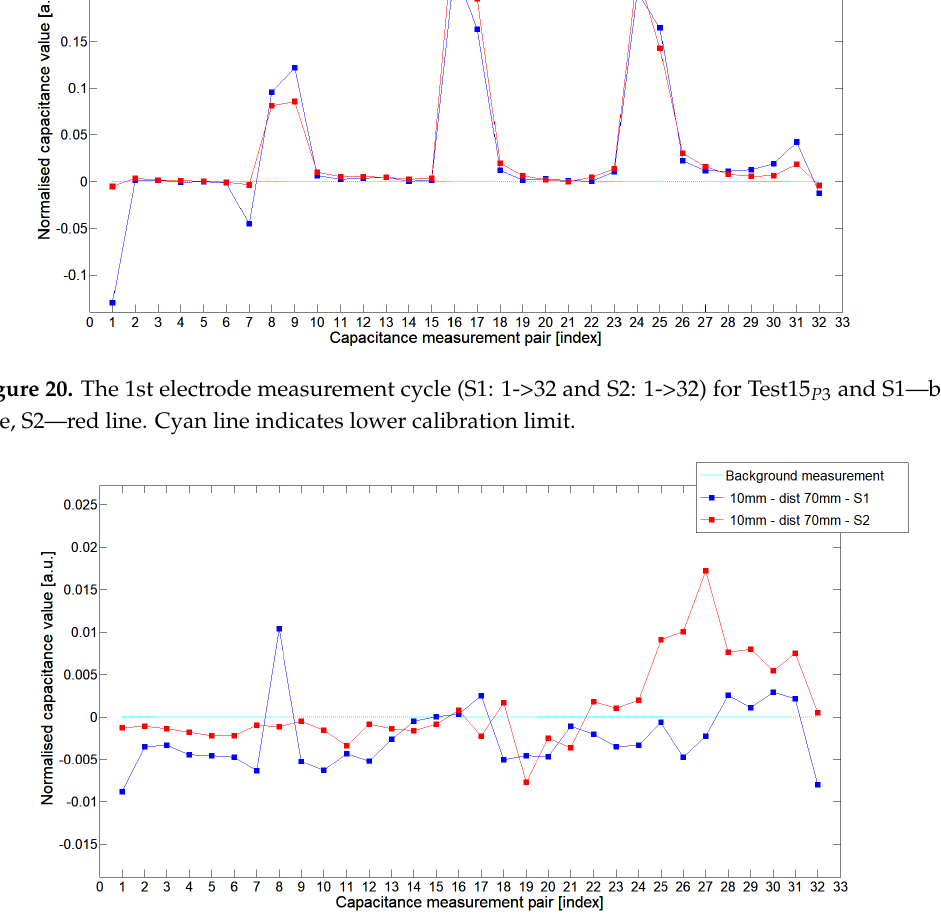
Figure 21. The 1st electrode measurement cycle (S1: 1->32 and S2: 1->32) for Test10 P 1 and S1—blue line, S2—red line. Cyan line indicates lower calibration limit.